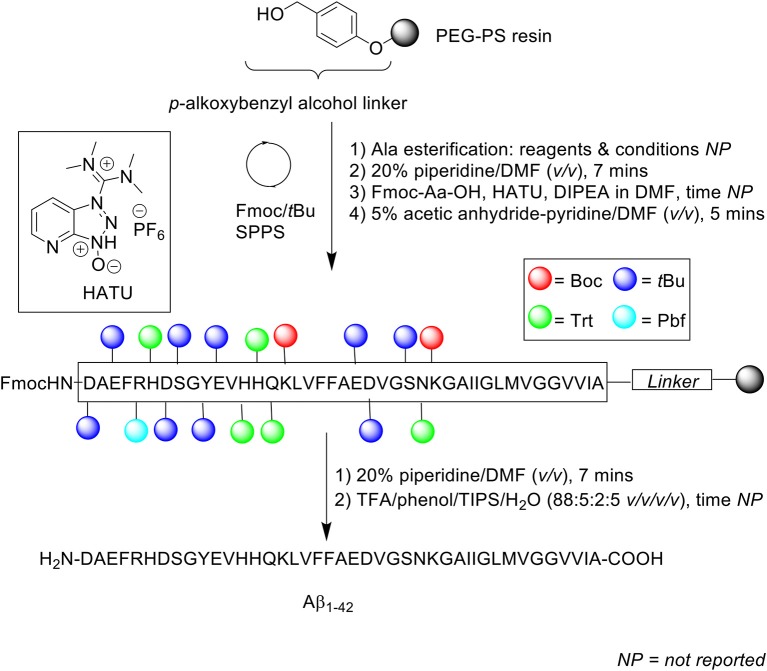
Fmoc/tBu SPPS of Aβ1−42 by Fukuda et al. (1999).